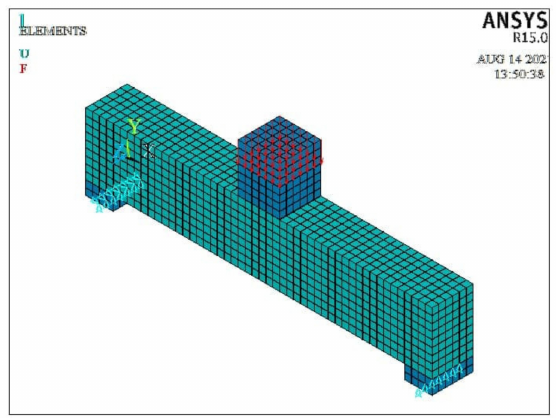
Figure 2. Finite element mesh, supports, and applied loading for the control beam model B1.